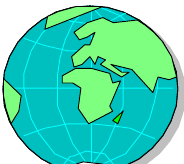
Figure 2. Our earth is not of perfect